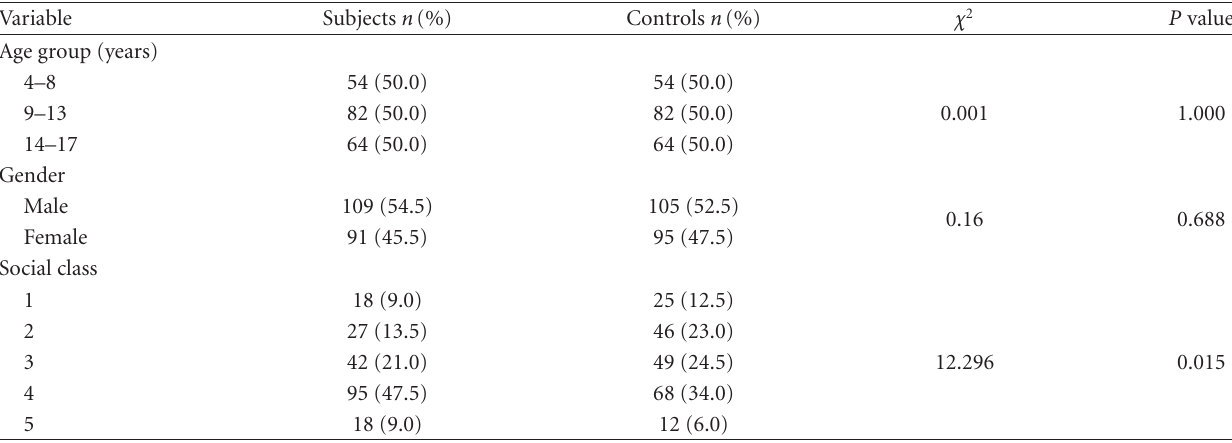
Table 1: Demographic characteristics of subjects and controls.